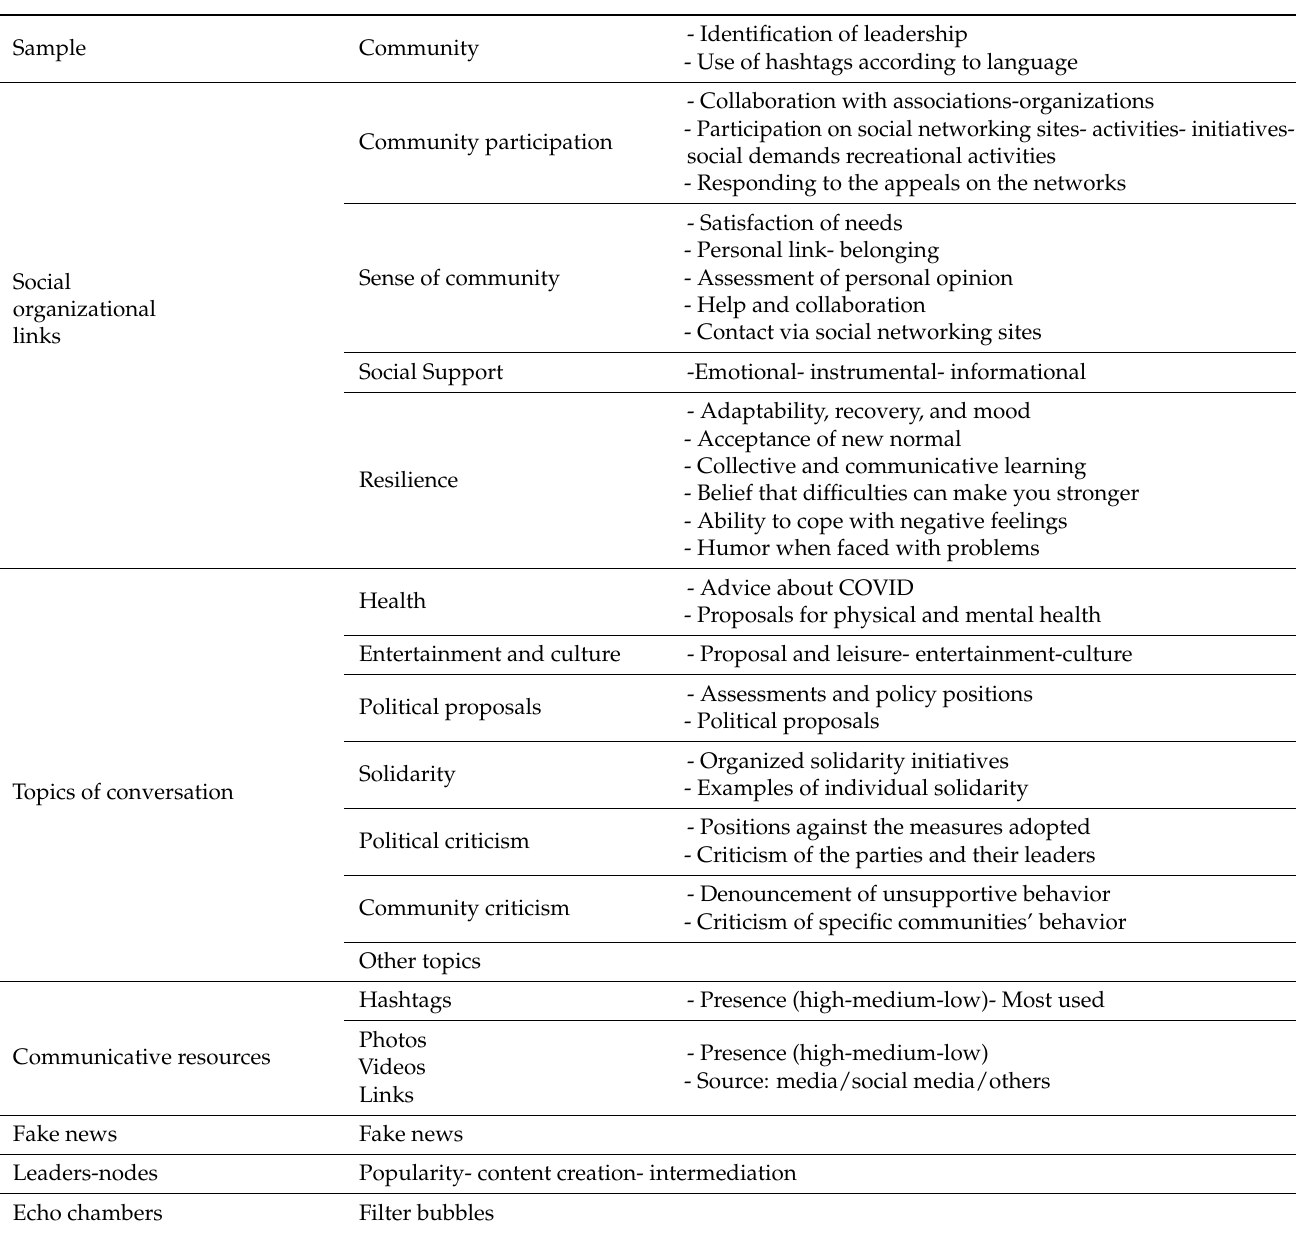
Table 2. Coding book used for netnographic